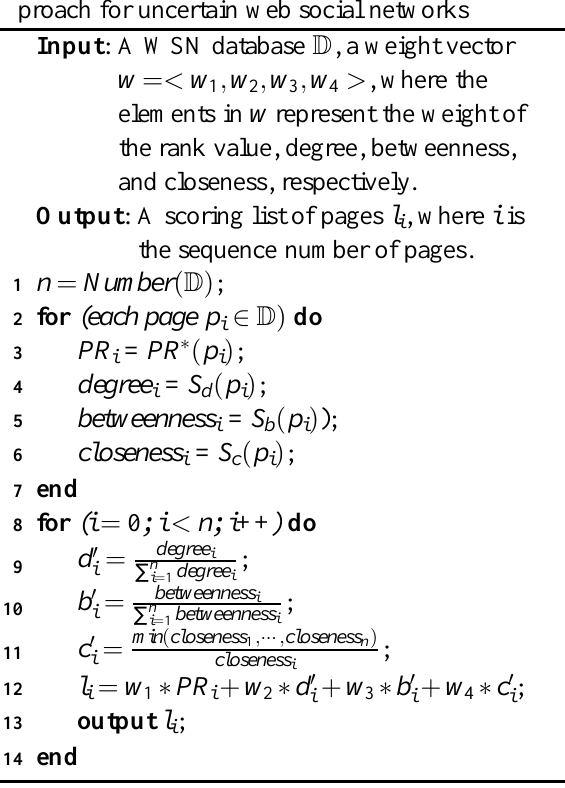
Algorithm 1 : An effective page scoring ap- proach for uncertain web social networks